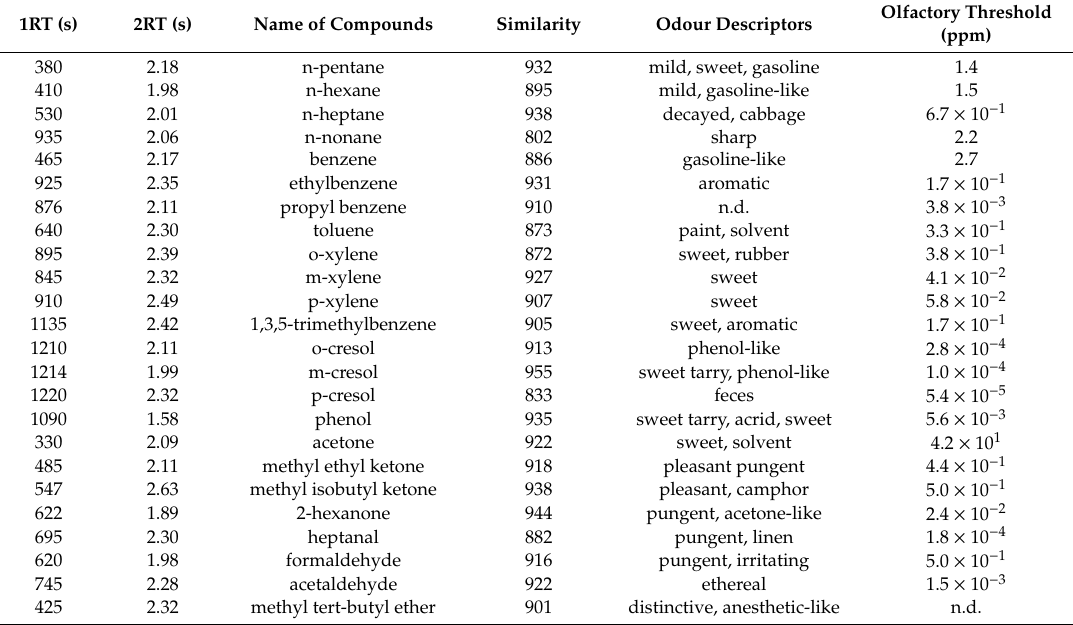
Table 3. Chemical compounds identified in this study (olfactory threshold values from [31]; n.d.—no data). 1RT